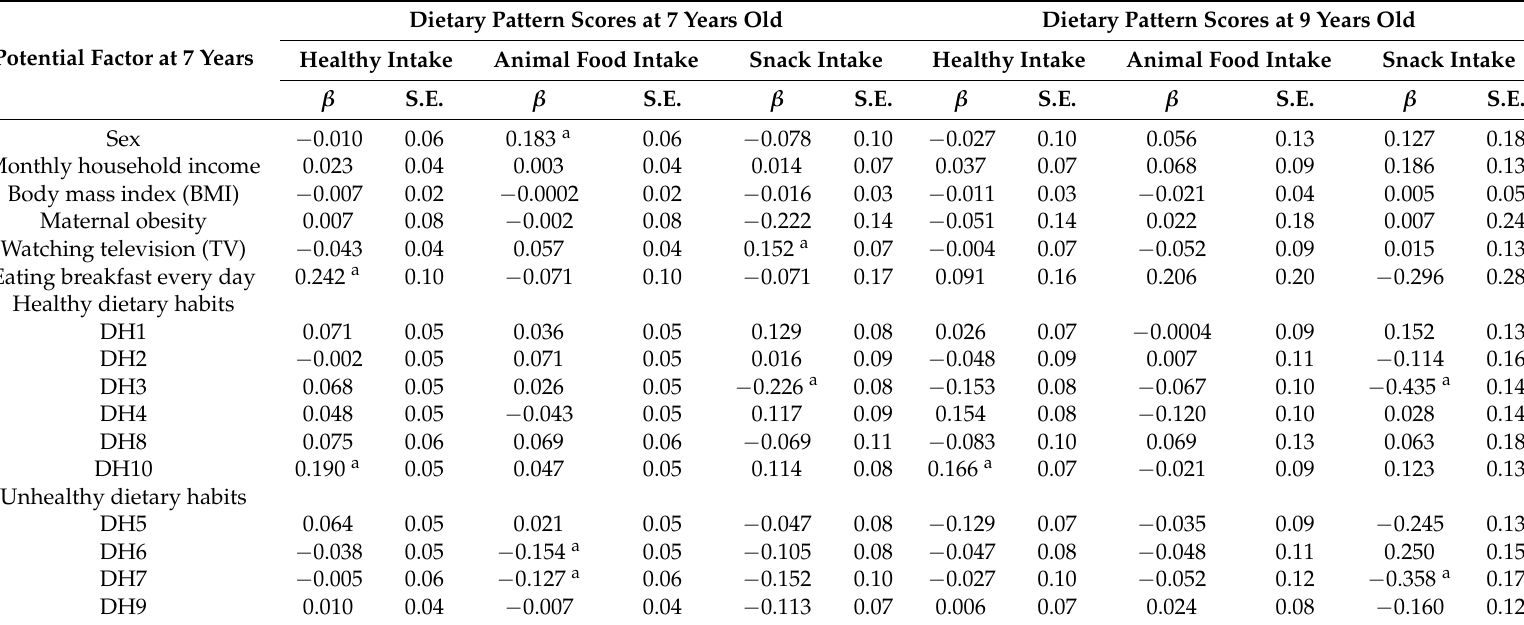
Table 2. Multiple regression analysis of the effects of potential factors on dietary pattern at two observation